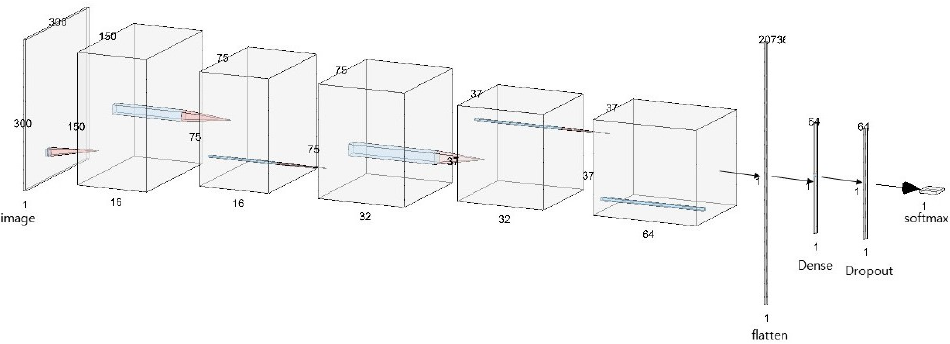
Figure 3. Proposed Architecture for Defect